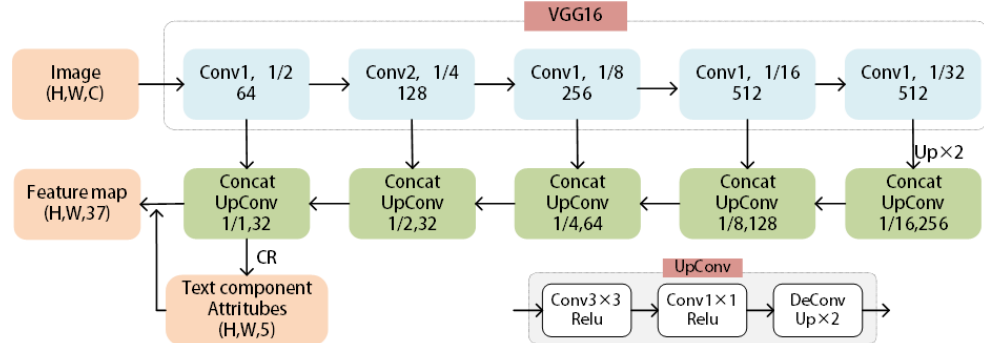
Figure 2. Architecture of the feature extraction network, where CR represents the classification and regression operation for the text components. CR ∈ R H × W × 5 has 2 channels for the logistic classification of text regions and 3 channels for the logistic regression of h 1, h 2, and θ .